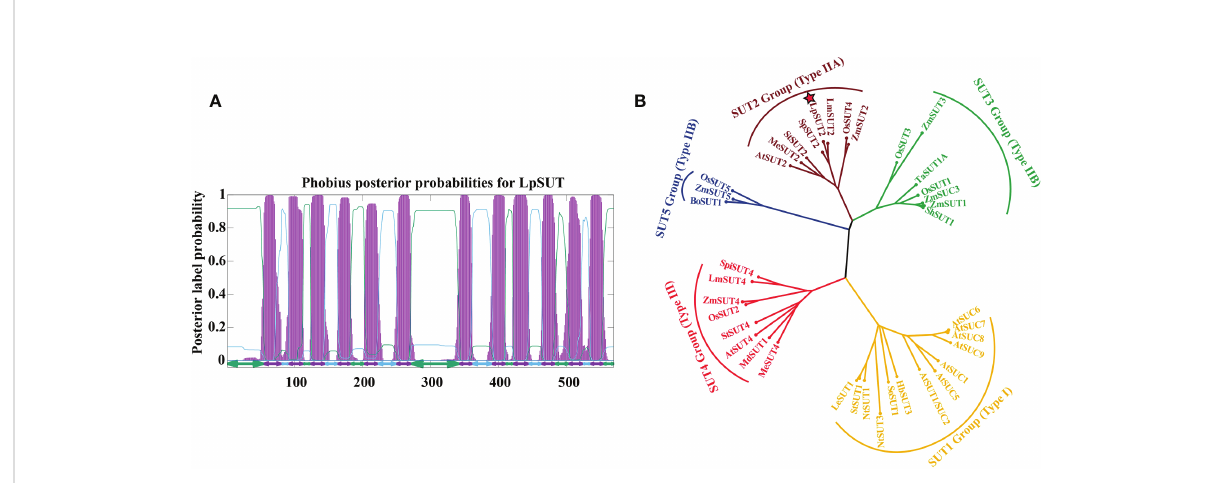
FIGURE 1 Sequence analyses of the LpSUT2. (A) 12 transmembrane domains were predicted in LpSUT2. The fi gure was produced using the Phobius server (https://phobius.sbc.su.se/) and Gnuplot software. (B) Phylogenetic tree was constructed using the analysis of the LpSUT2 and SUTs proteins from other plant species. Sequence names and accession numbers are provided in Table S1. The bootstrap consensus tree from 500 replications was created based on the NJ (neighbor-joining) method, using MEGA 6.0. LpSUT2 sequence falls into IIA clades (SUT2 subfamily). LpSUT2, Sucrose transporter 2 of L. punctata